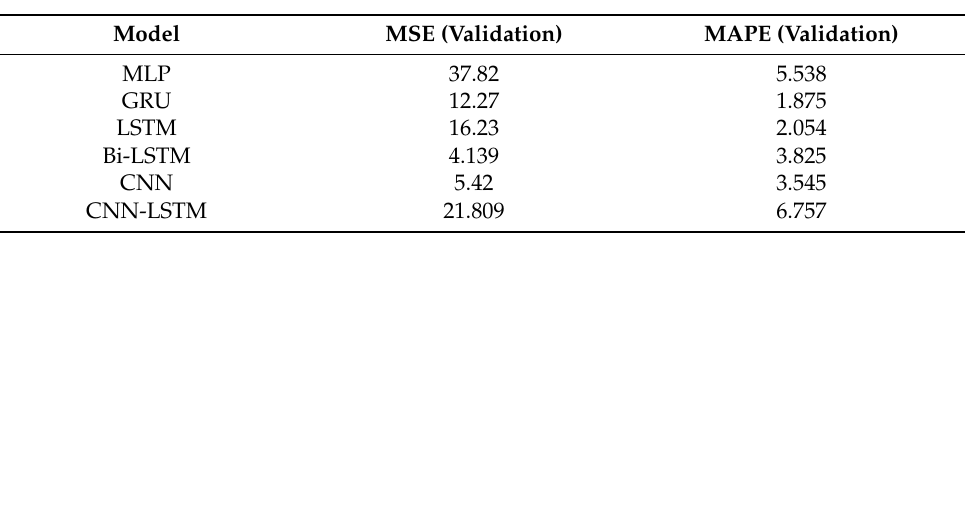
Table 14. The validation results of the models using Snapchat data with four input